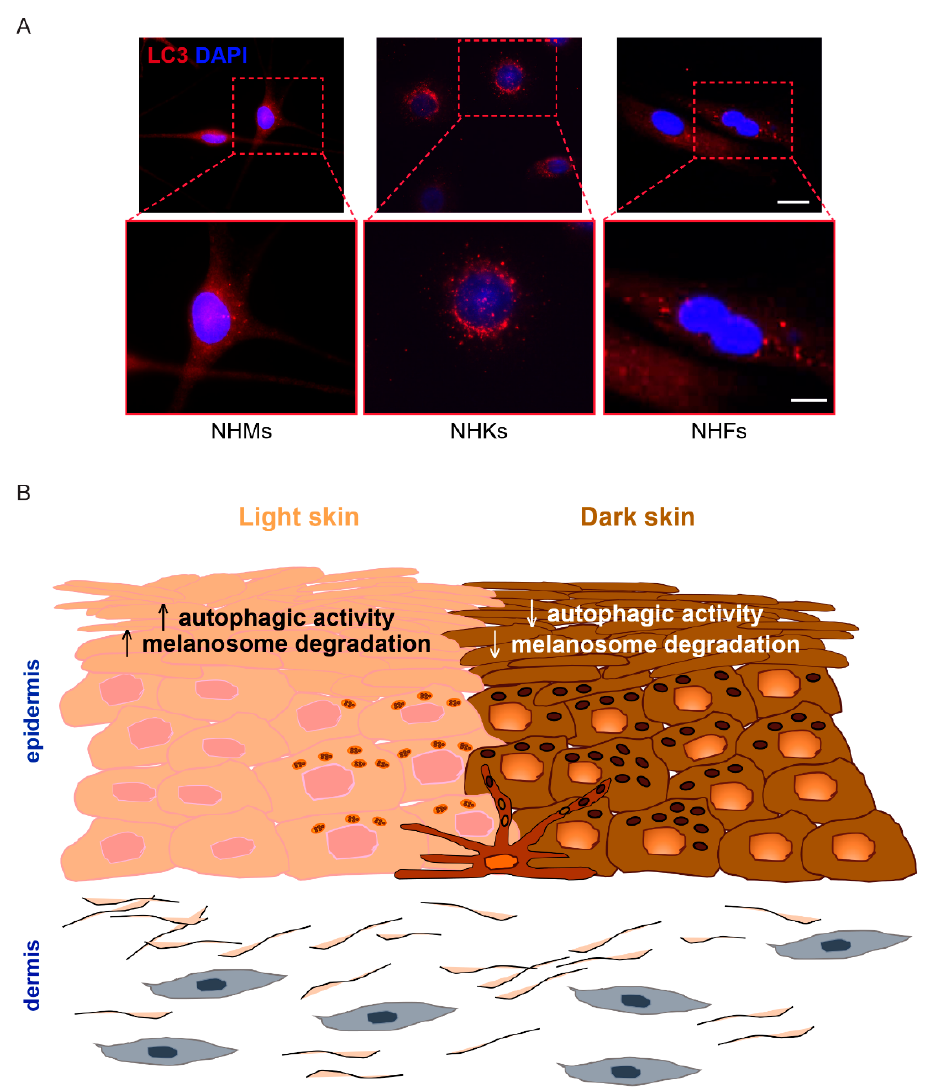
Figure 1. Skin color and autophagy. ( A ) Immunofluorescence analysis was performed on primary cultures of normal human melanocytes (NHMs), normal human keratinocytes (NHKs) and normal human fibroblasts (NHFs) using an antibody (red signal) directed against the autophagy marker light chain 3 (LC3I/II). Nuclei are counterstained with DAPI (blue signal). Scale bars: 20 µ m; enlarged view of the boxed area: 10 µ m. ( B ) Autophagic activity is involved in skin color variation by regulating melanosome degradation.